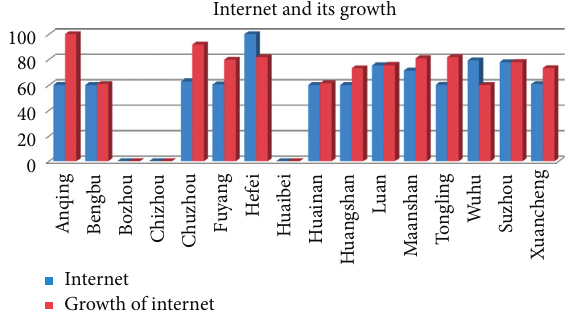
Figure 5: Internet and its growth.